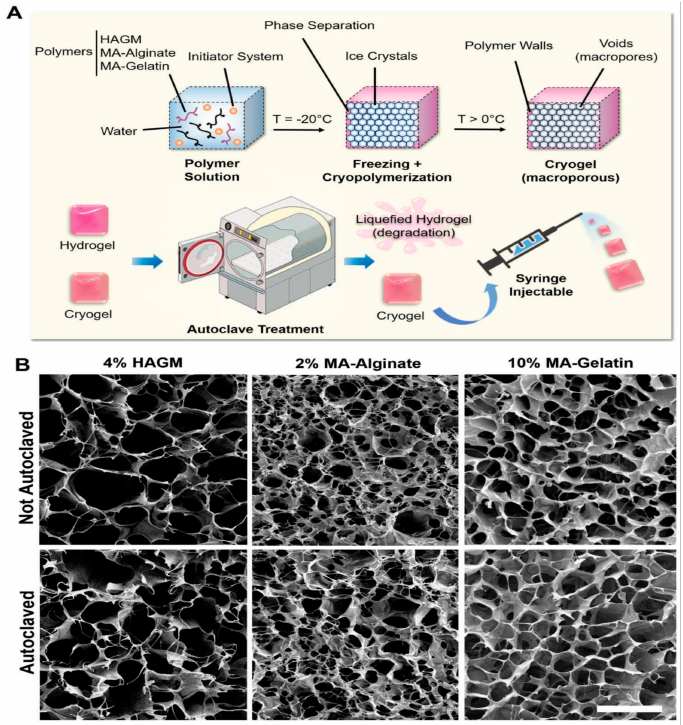
Figure 6. Developing different types of injectable cryogels with different polymers and autoclaving process. ( A ) Stages of the preparation process of cryogels combined with autoclaving sterilization. ( B ) SEM images of HAGM, MA-alginate and MA-gelatin cryogels (scale bar = 100 µ m) [81]. Shih et al. produced an injectable tough MA-alginate cryogel as a cancer